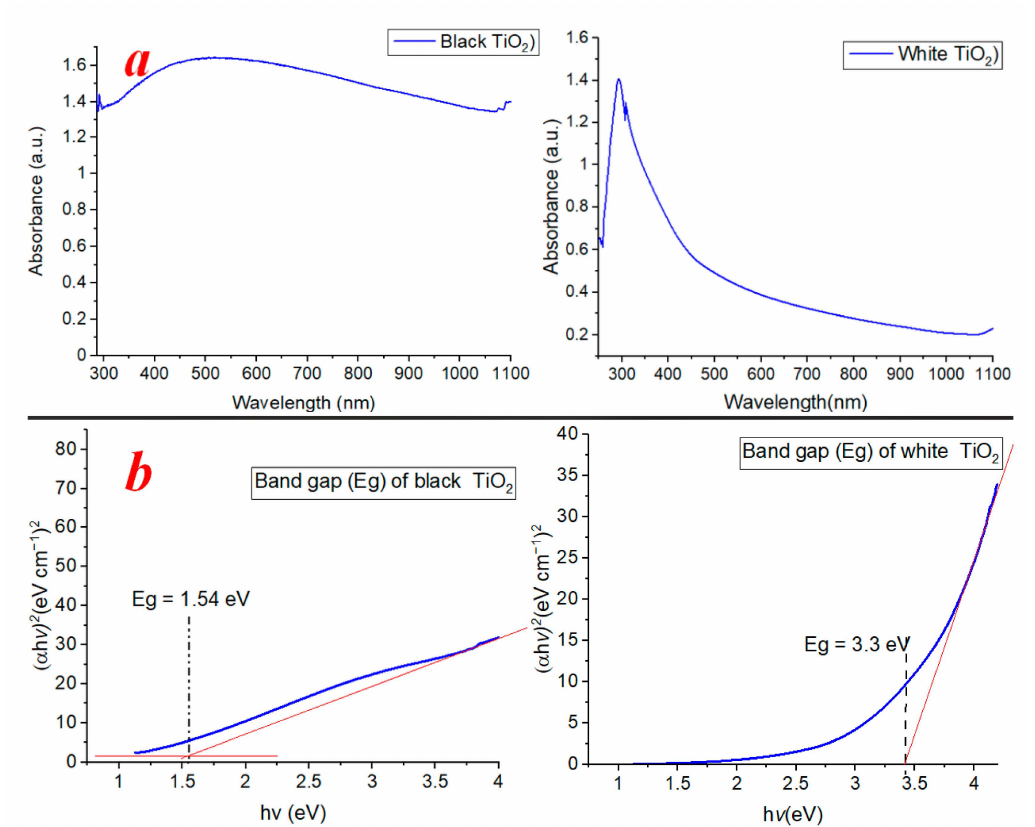
Figure 10. UV–Vis NIR absorption spectra ( a ) and band-gap energy ( b ) of the black TiO 2 and pristine TiO 2 estimated from their corresponding Tauc